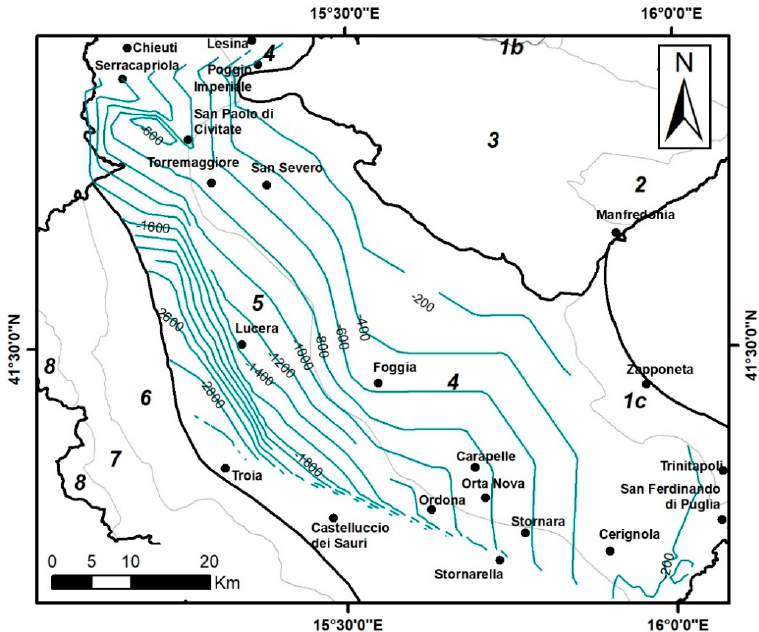
Figure 4. Map of the carbonate bedrock isobaths (blue lines) within the BT domain obtained interpolating the data from L464/84 wells and ViDEPI Project investigations. Thick black and grey lines represent the morphostructural domain and subdomain borders, respectively. Black points indicate the locations of the main urbanized areas of the Bradanic Trough.